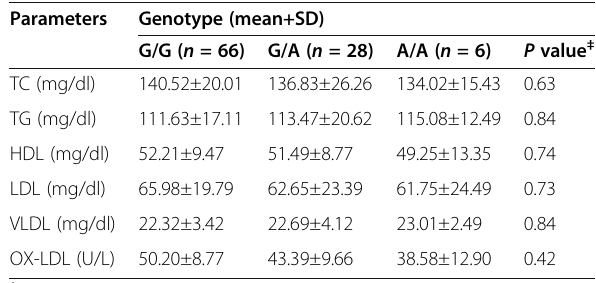
Table 5 The impact of the ApoB rs676210 polymorphism on the lipid profile and oxLDL of the control group